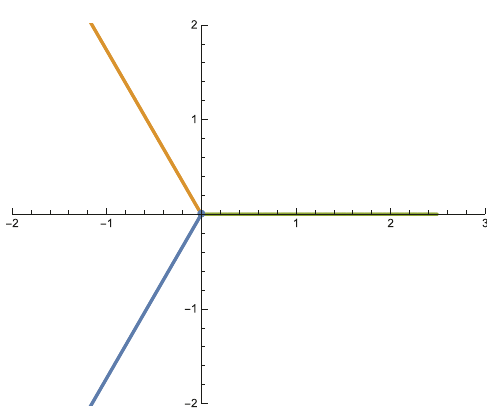
Figure 1 . The Stokes lines of the Airy function, which are the solutions of Im[ s ( x )] = 0 , are plotted on the complex x -plane. The classical turning point of the Schrödinger equation is shown at the origin.